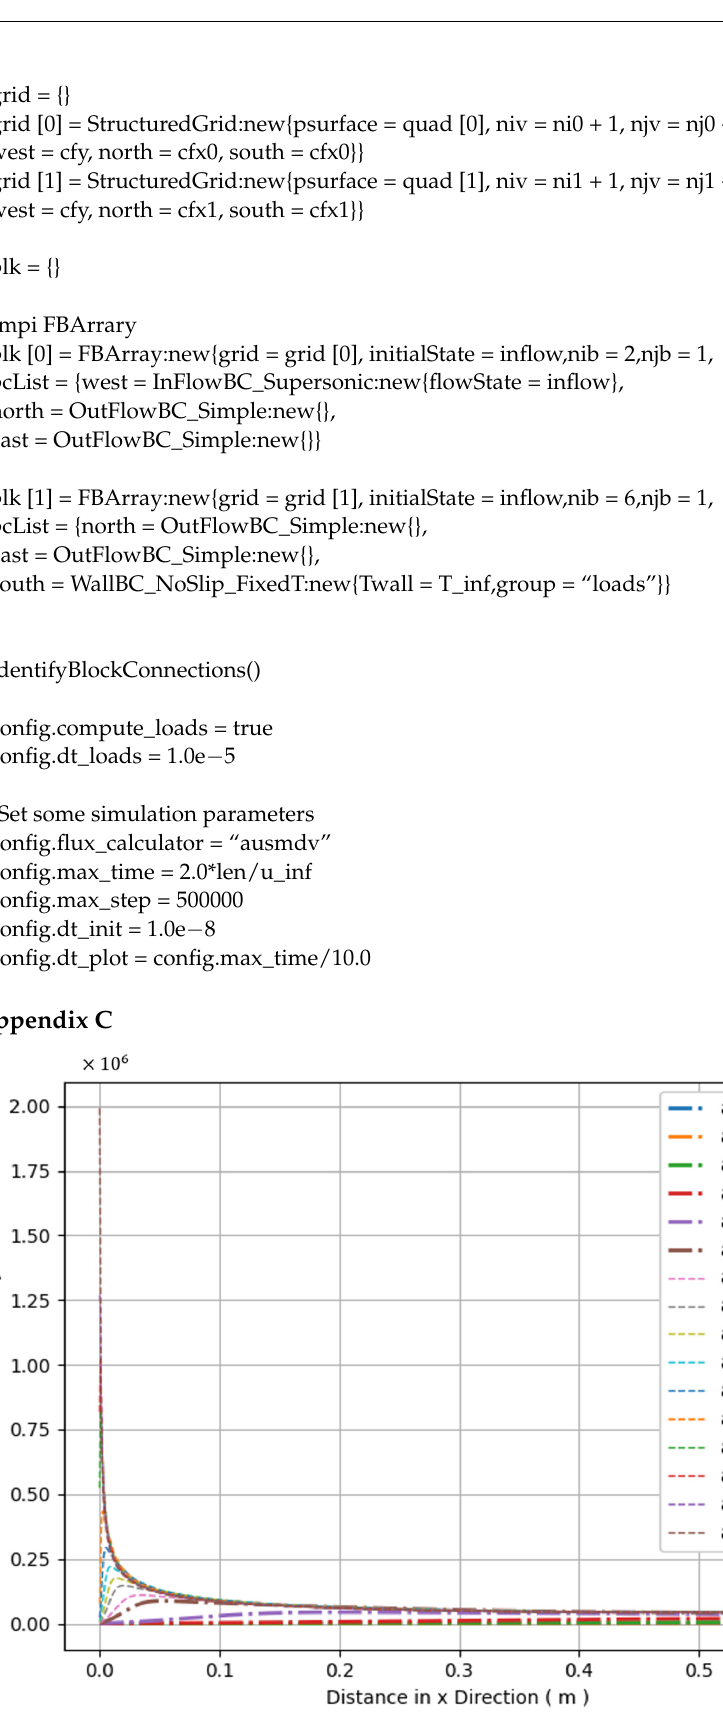
Figure A1. Grid convergence study of cell ratio ‘a’ in SA model.